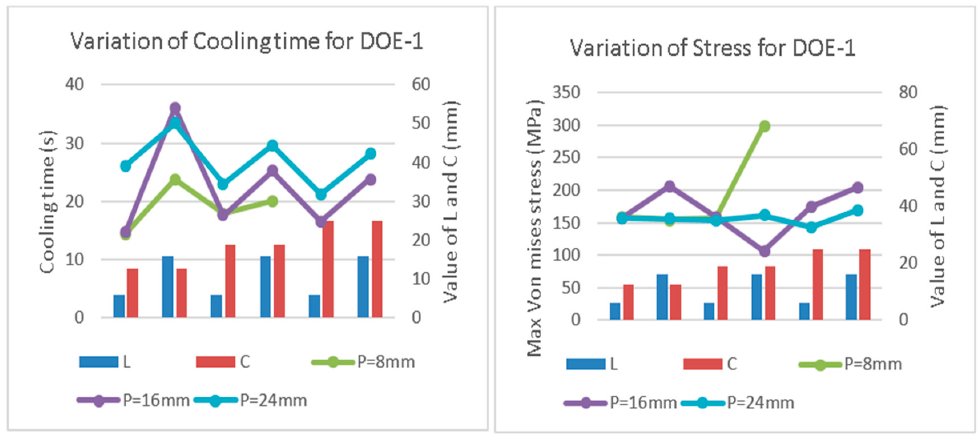
Figure 3. Trend of cooling time and maximum von Mises stress variation in DOE-1.